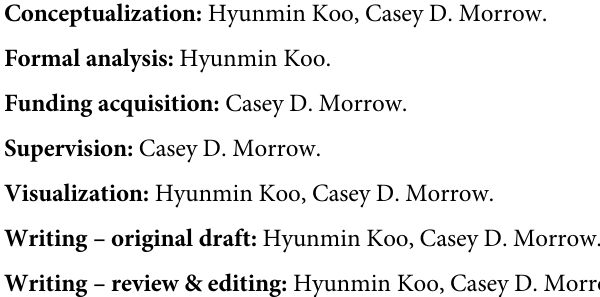
S1 Table. Sample and sequence read information. The original sequence files were sequenced and deposited by Davar et al. in the BioProject database under accession number PRJNA672867. The table represents the sample information with sequence read information used for the analysis in this study. S2 Table. Taxonomic profile. Microbial community composition was profiled at the species level for (A) donor 18–0002, recipient 18–0018, (B) donor 18–0014, recipient 19–0024, (C) donor 18–0031, recipient 19–0013, (D) donor 18–0006, recipient 19–0002, and (E) donor 18– 0005, recipient 18–0007 from Davar data set. The number shown in the table shows the relative abundances obtained using